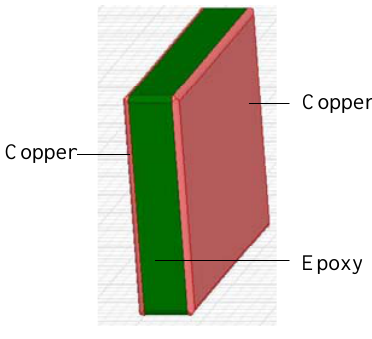
Figure 4. Simulation model of measuring sensor.